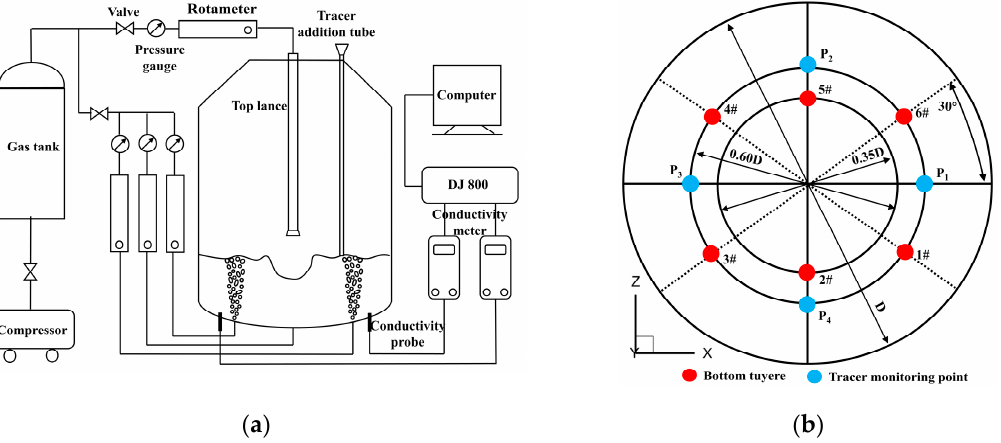
Figure 1. Schematic diagrams of ( a ) the hydraulic experiment device and ( b ) the arrangement of the bottom tuyeres and tracer monitoring points.